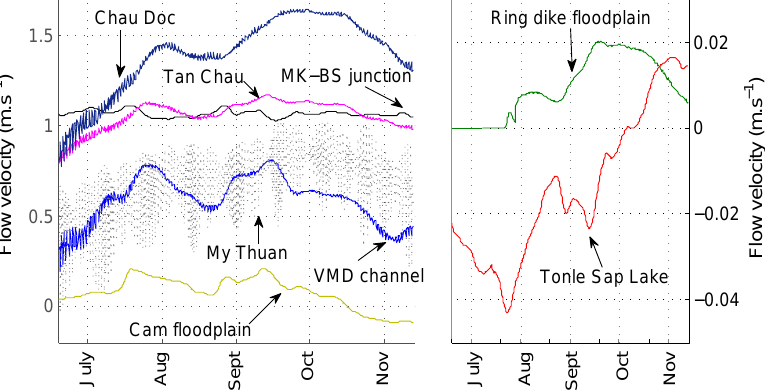
Figure 6. Flow velocity time series with 6h time steps of all the sub-systems in the MD in 2009. Flow velocities of some key locations in the main rivers and in a VMD channel in the PoR (left panel, MK–BS = Mekong–Bassac), flow velocities in the center of the TSL and a floodplain compartment in the PoR (right